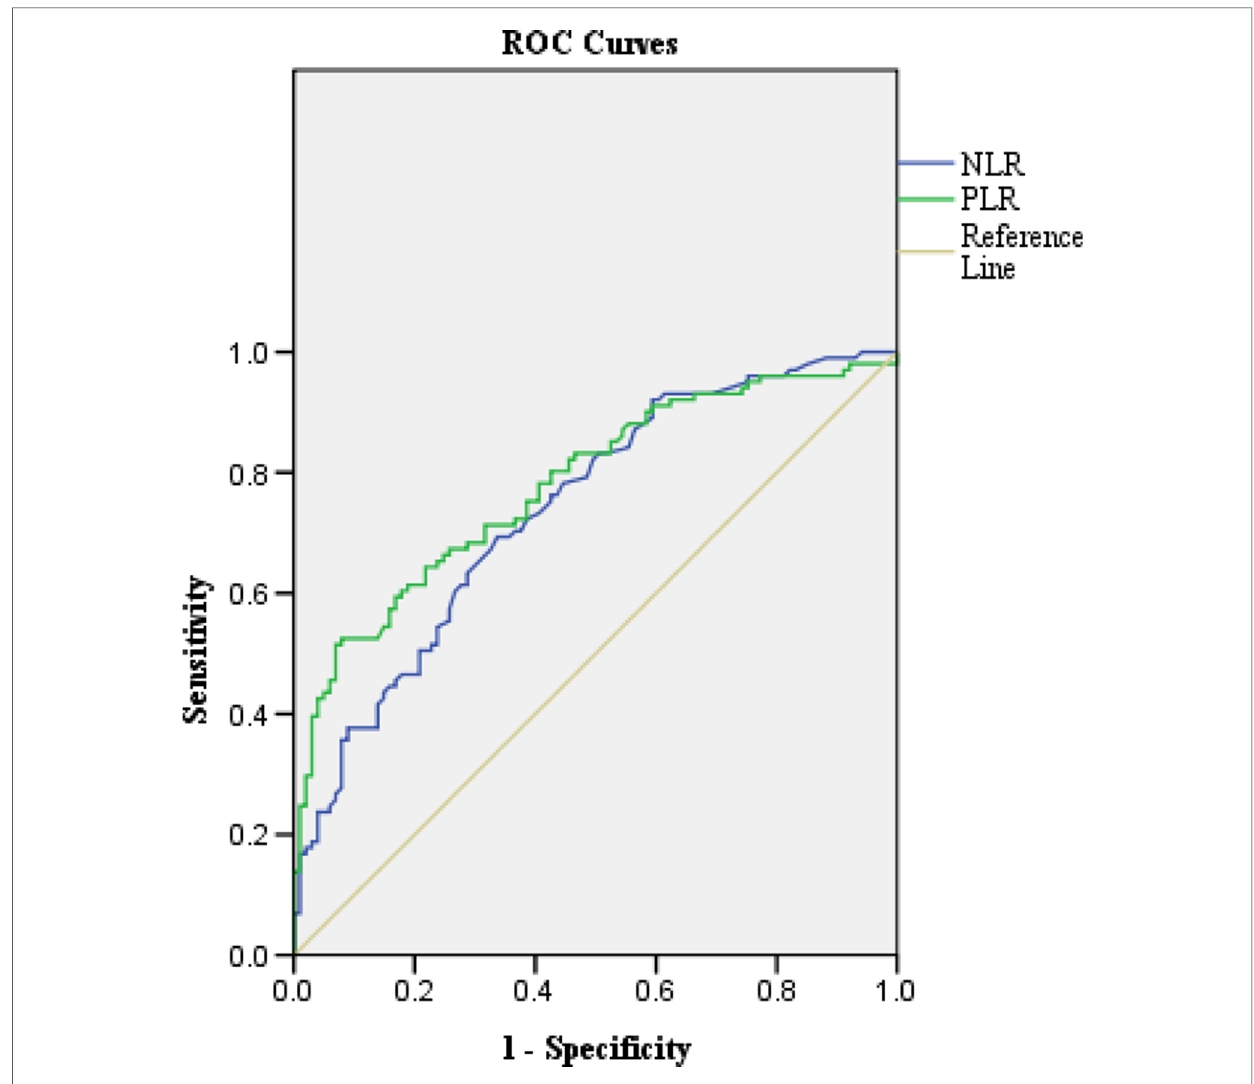
FIGURE 1 ROC analysis of NLR and PLR, as predictive values in hepatoblastoma.